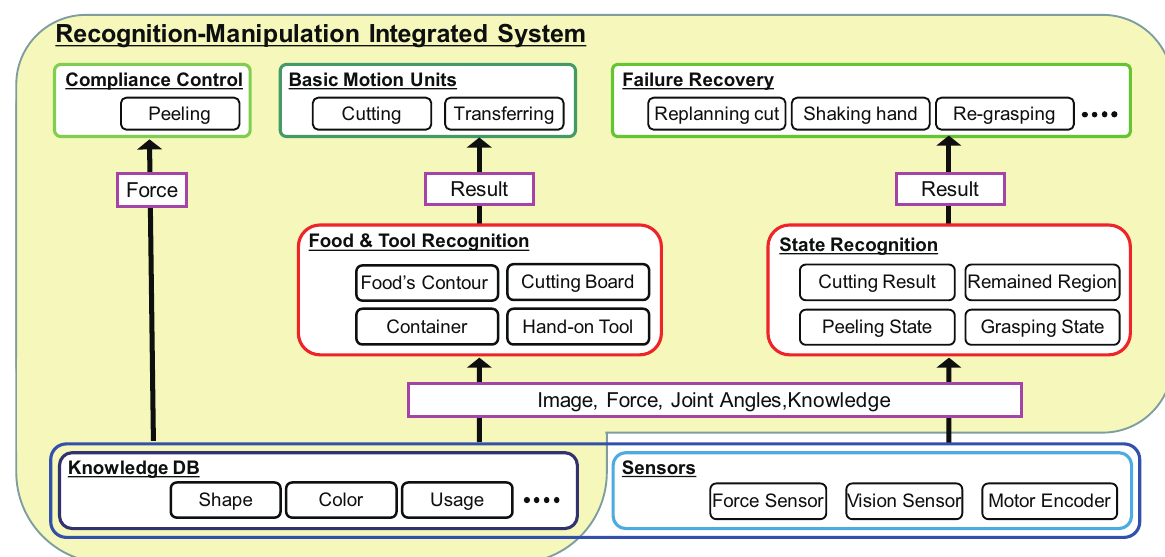
Figure 2. A cooking system integrating recognition and motion generation